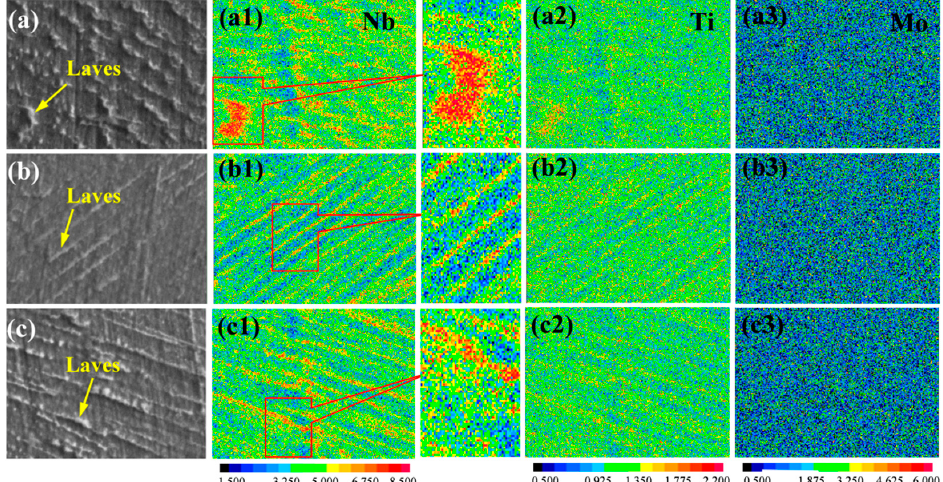
Figure 7. Cross-section EPMA maps of the SLMed Inconel 718 under different volume energy densities, including 85.86 J/mm 3 ( a – a3 ), 100 J/mm 3 ( b – b3 ), and 117.17 J/mm 3 ( c – c3 ). Table 4. EPMA quantitative analysis results for the position P1 (A) and P2 (B) of Figure